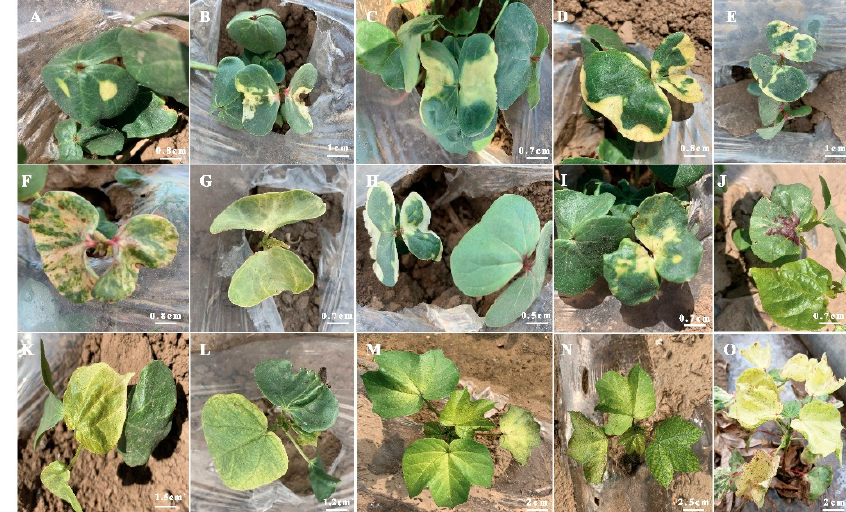
Figure 5. Yellow and yellow-green leaves of EMS-induced mutants ( A – J ) cotyledon leaves with different shades and positions of yellow color and anthocyanin pigments, ( K – O ) young true leaves with different shades of yellow and yellow-green color.